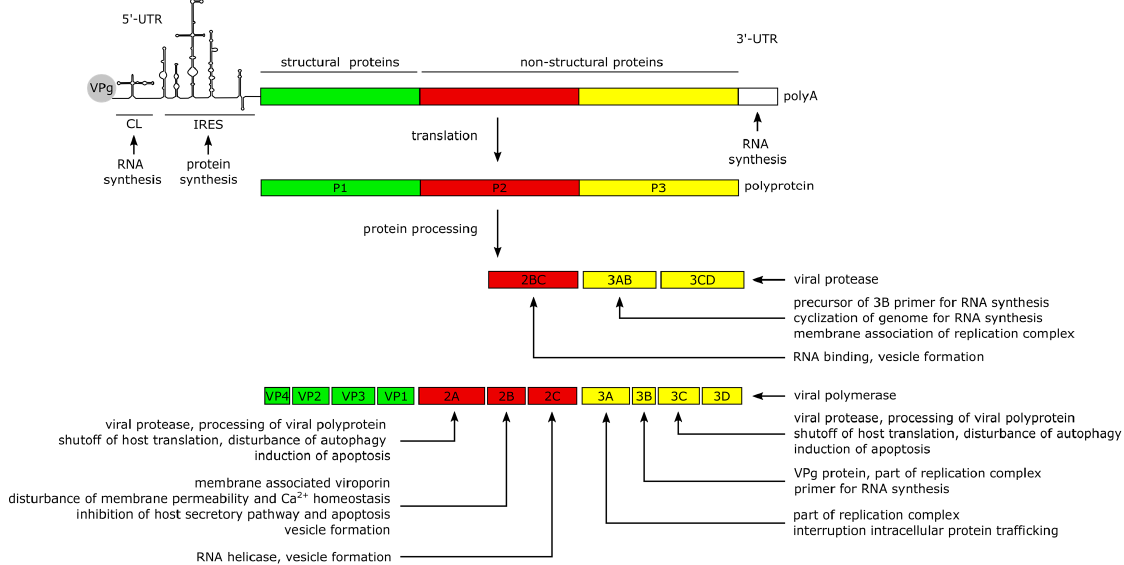
Figure 2. Structure of the CVB3 genome and the functions of the viral proteins. The ~7.5 kb viral genome comprises a 5‘-UTR with the cloverleaf (CL) structure and the internal ribosomal entry site (IRES), modelled according to Bailey et al. [40], an open reading frame and a 3′-UTR with a poly(A) tail. The small VPg protein binds to the 5′-end of the genome. The open reading frame is translated into a polyprotein which is autocatalytically processed into the structural (green) and non-structural (red and yellow) proteins. During the pro- cessing of the non-structural proteins, three precursor proteins (2BC, 3AB, 3CD) with distinct functions in the viral life cycle are formed, which are processed further into the seven non-structural proteins (2A, 2B, 2C, 3A, 3B, 3C, 3D).